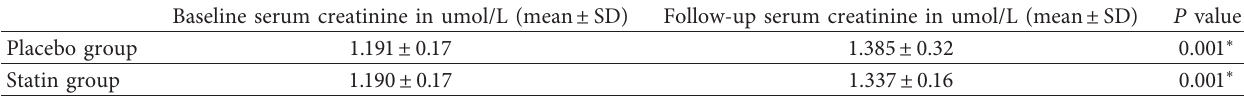
Table 3: Comparison of serum creatinine level before and after intervention among both study